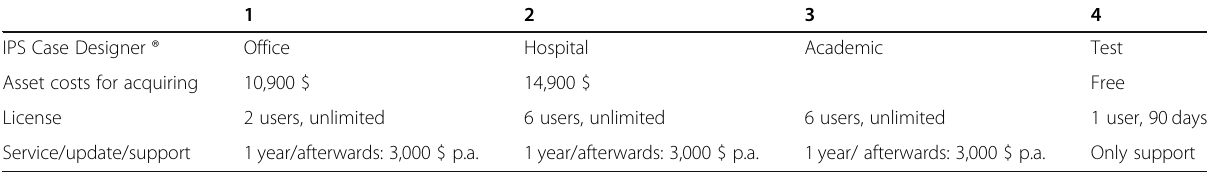
Table 1 Overview of the costs for the VSP system IPS Case Designer ®